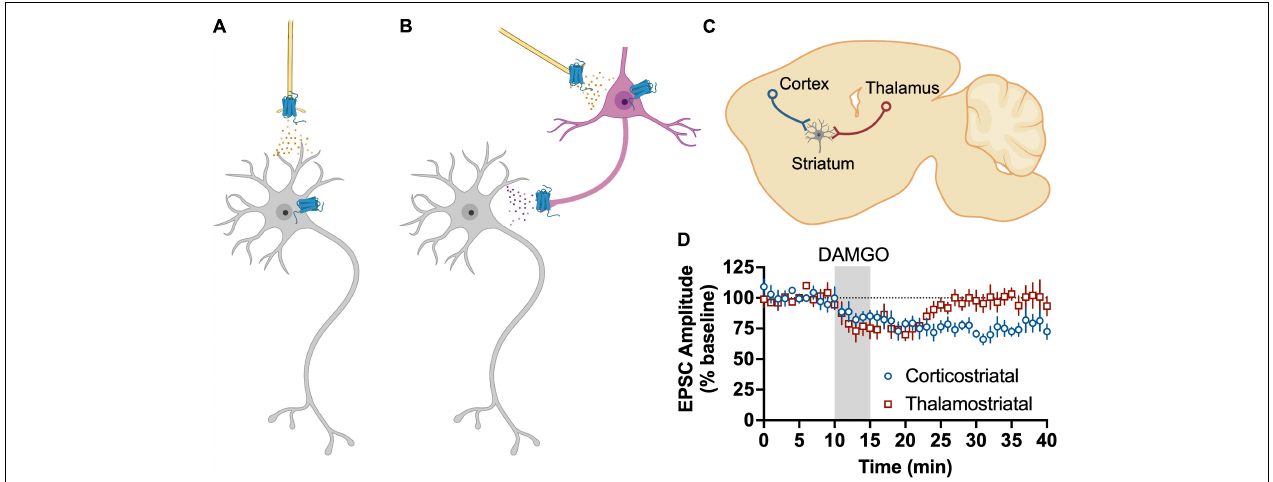
FIGURE 2 | Summary of opioid receptor-mediated modulation of neurotransmission. Opioid receptor activation-mediated modulation of neurotransmission can have differential effects on neurocircuit function depending on the localization of the receptors. (A) Opioid receptors found on glutamatergic terminals will reduce glutamate release upon activation, thus inhibiting a postsynaptic neuron. Opioid receptors on postsynaptic neurons will generally reduce neuronal excitability. (B) Opioid receptors found on inhibitory neuron (e.g., GABAergic) terminals or postsynaptically will reduce inhibitory transmission, disinhibiting a postsynaptic neuron. Alternatively, opioid receptors on glutamate neurons that impinge on inhibitory neurons will reduce excitatory drive of these neurons, thus reducing inhibitory transmission and producing disinhibition through a polysynaptic mechanism. (C) Opioid receptors localized to different synaptic terminals can produce differential outcomes upon activation. As an example from our own work, MORs are localized to cortical and thalamic glutamatergic inputs to dorsal striatum (DS). (D) Upon activation by the MOR agonist, DAMGO, MORs reduce the amplitude of glutamate-mediated excitatory postsynaptic currents (EPSCs). Activation MORs on glutamate inputs from cortex produces a long-lasting reduction in EPSC amplitudes. However, activation of MORs on thalamic inputs only produces a transient reduction, despite also being a glutamatergic input to the same neurons that express the long-lasting reduction in glutamate transmission from cortical inputs. Adapted from data from Munoz et al. (2018). Figure created with